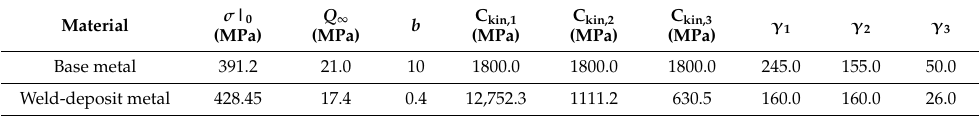
Table 2. Cyclic hardening parameters of Q345qC steel